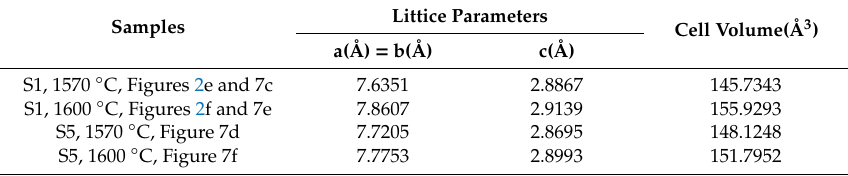
Table 3. Weight fraction of each phase in S1 and S5 at 1570 and 1600 ◦ C (wt. %).